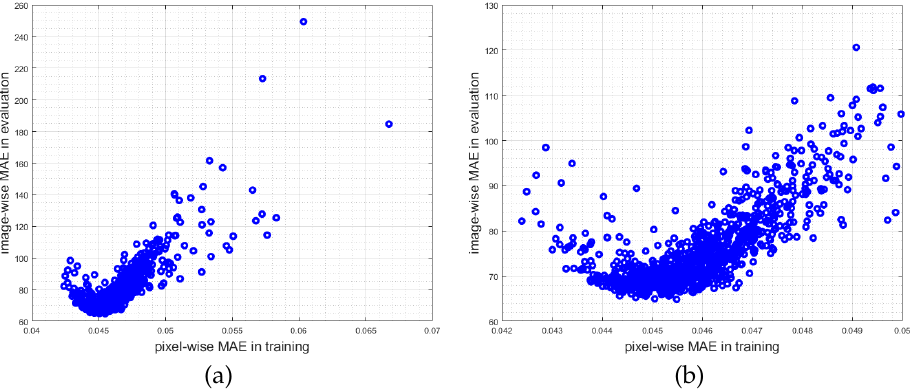
Figure 12. Scattergrams of pixel-wise mean absolute error (MAE) during training with resulting image-wise MAE in evaluation. ( a ) Scattergram for the complete data. ( b ) Scattergram only showing pixel-wise MAEs during training with values below 0.05, such that this plot is a zoomed version of ( a ). A non-linear correlation between both measures in